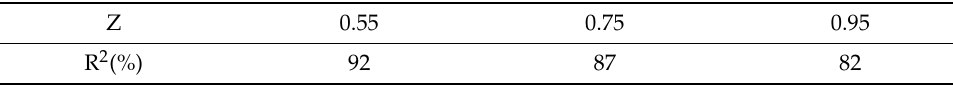
Table 2. R 2 of axial